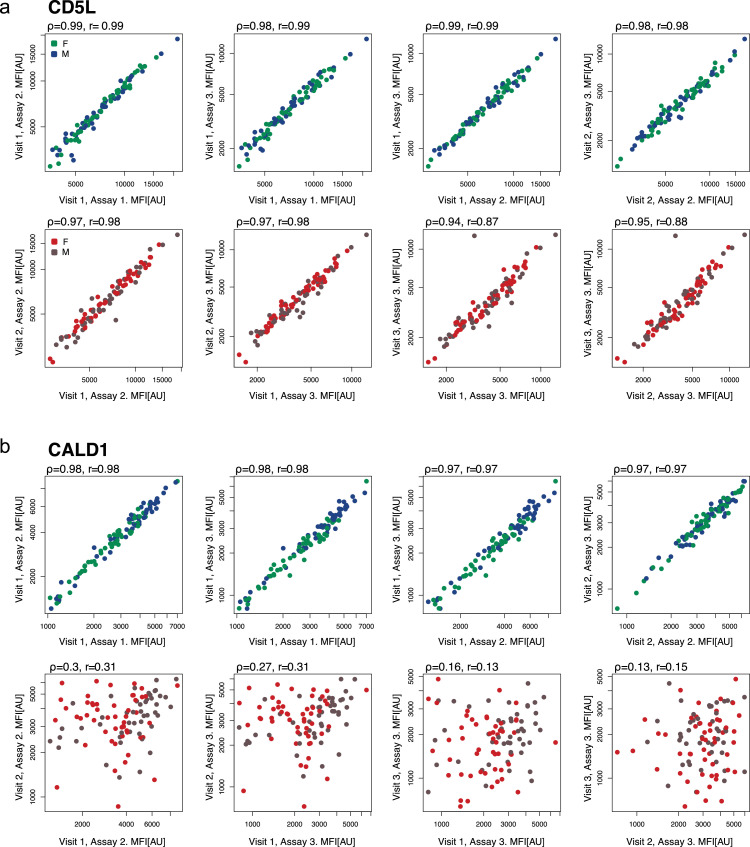
Inter-assay and inter-visit variability. Shown are correlations of technical (inter-assay, upper panel) and longitudinal (inter-visit, lower panel) profiles. (A) CD5 antigen-like (CD5L) represents a both technically and longitudinally stable protein, while levels of (B) Caldesmon 1 (CALD1) vary between visit but not repeated assays. Each dot represents one individual, coloured by sex (F, female; M, male), MFI relates to median fluorescent intensity and AU are arbitrary units. Correlations are indicated by ρ (Spearman's Rho) and r (Pearson correlation coefficient).